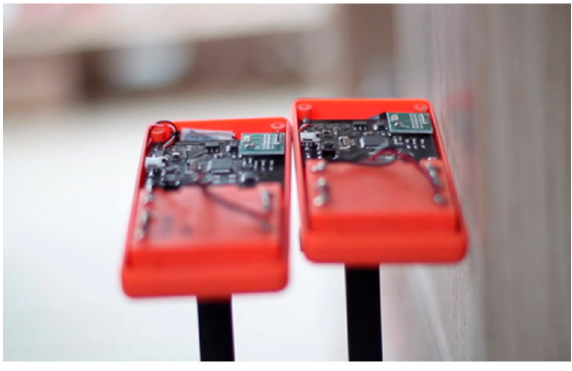
Figure 20. Sensors for monitoring housing.